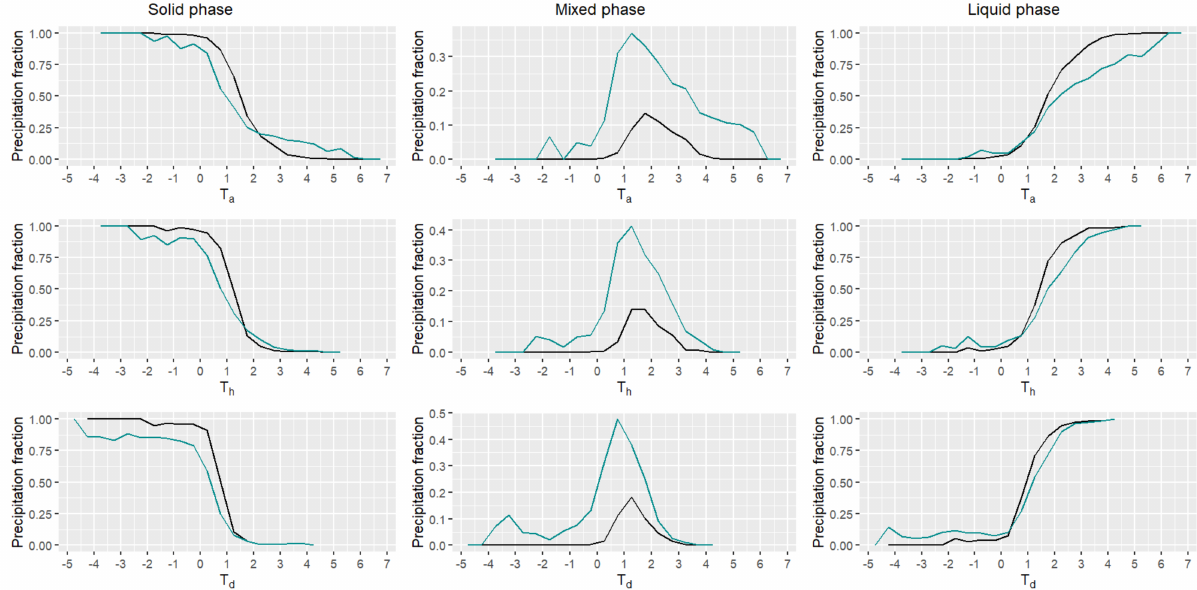
Figure 3. Plots of T a , T h , T d (from top to bottom) shown for solid, mixed, and liquid precipitation (from left to right). The “S” curves in cyan were plotted from the observed data, and the black curves were plotted with data after multidimensional K–means outliers’ detection. Temperature class is in the horizontal axis in all plots and is represented by the median value per